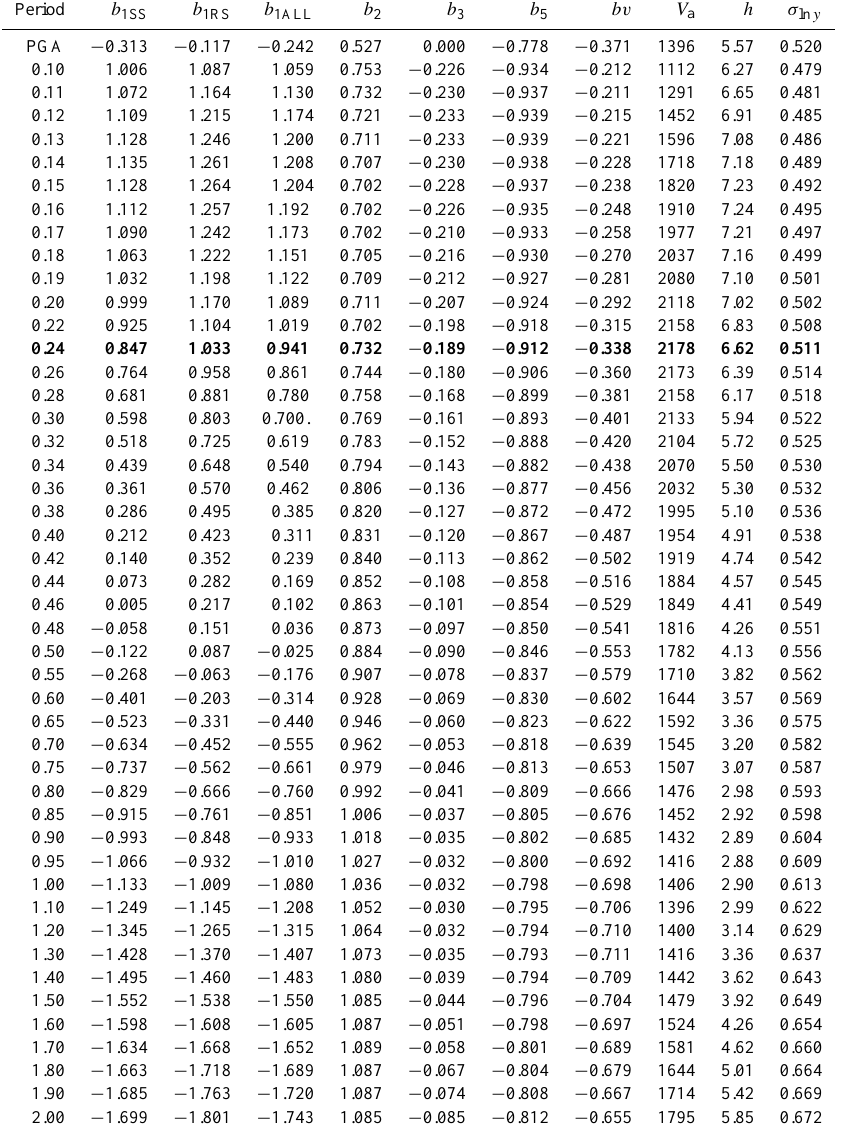
Table 3. Smoothed coefficients for Boore et al. (1997) PGA and SA attenuation